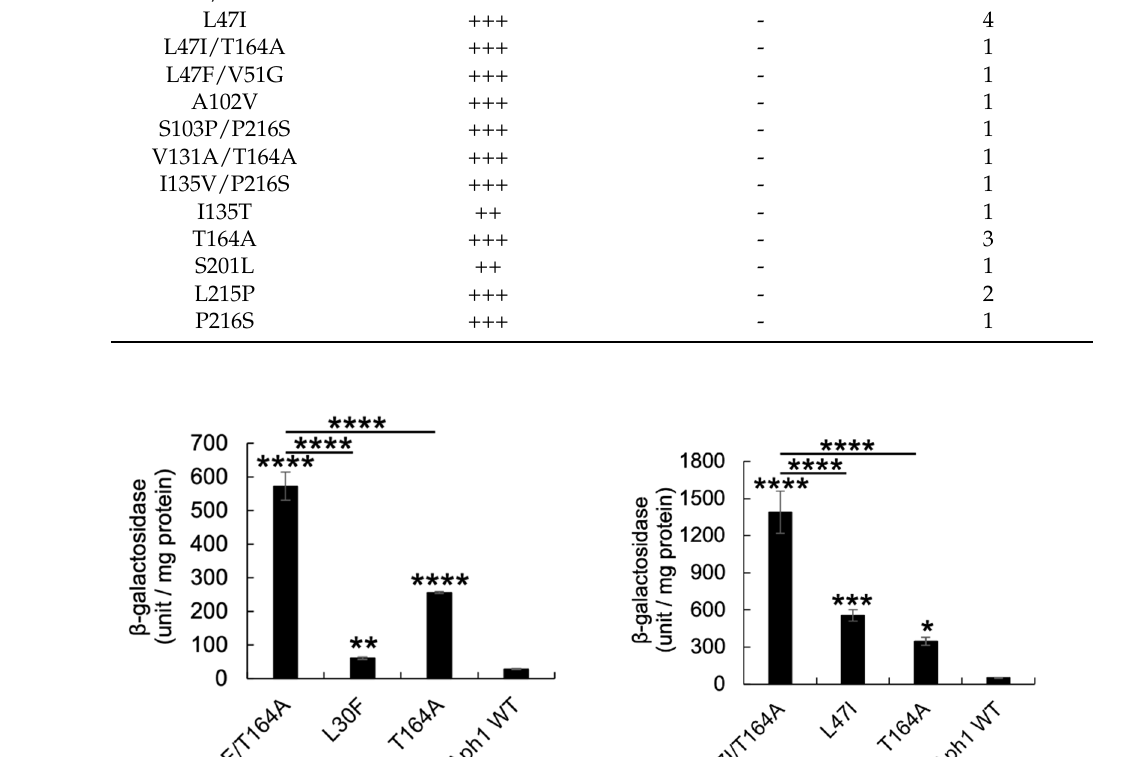
Table 1. Screening for Aph1 mutants active without NCT. The growth of cells with APP-Gal4, PS1 S103P/P216S +++ (WT or S438P), and Pen2 were analyzed on SD-LWHUAde medium after 3 days at 30 ◦ C. “+++” V131A/T164A +++ - represent full growth, cells formed colonies (>1 mm); “++” represent partial growth with colonies I135V/P216S +++ - (>0.5 mm); and “-” represent no growth. 1.1 × 10 6 Cells were screened. I135T ++ - T164A +++ Aph1 Mutants Growth with PS1S438P Growth with PS1WT No. of Clones S201L L30F/T164A +++ - - β -Galactosidase activity determined the cleavage of APP C55 -Gal4p by Aph1 mutants. Aph1 L30F/T164A, L47I/T164A, L47F/V51G, S103P/P216S, V131A/T164A, and I135V/P216S possessed high activity (Figure 2a–f), compared to cells with each replace- ment. L30F, L47I, S103P, V131A, I135V, T164A, and P216S showed low but significant ac- tivities (Figure 2a-f). L47F and V51G showed diminished activities (Figure 2c), suggesting that two mutations are required for full activation. Including mutations regarded as single mutants (Figure 2g), we identified 10 primary mutations that activate γ -secretase (10% to 40% of wild-type Aph1 with NCT), and two secondary mutations that act only in combi- nation (Figure 1).